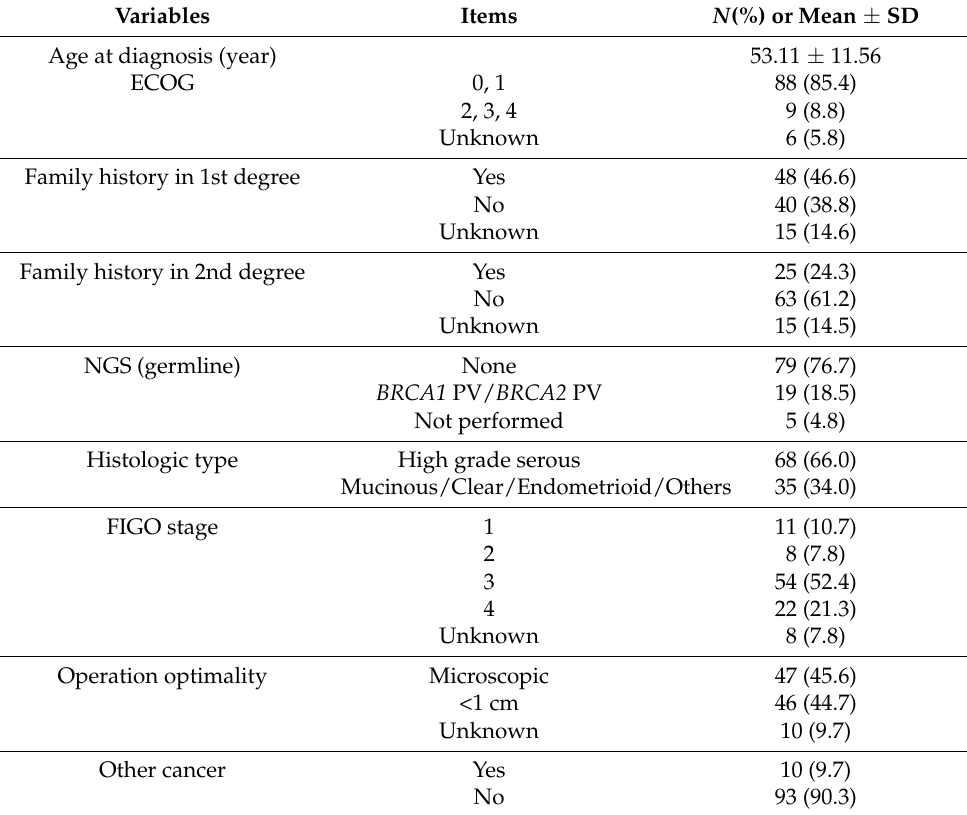
Table 1. Clinico-pathological characteristics ( N =